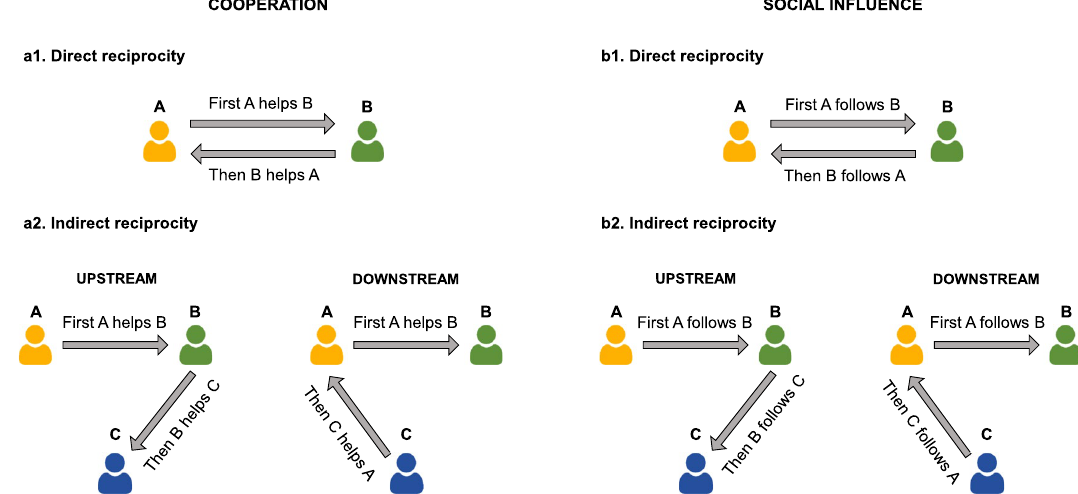
Figure 1. Schematic representation of direct and indirect reciprocity in cooperation ( a1 , a2 ) and social influence ( b1 , b2 ) scenarios. ( a1 ) Direct reciprocity in cooperation. An agent A benefits an agent B and then B benefits A. ( a2 ) Indirect reciprocity in cooperation. In upstream indirect reciprocity, an agent A benefits an agent B and then B benefits a third agent C. In downstream indirect reciprocity, A benefits B and then C benefits A. ( b1 ) Direct reciprocity in social influence. An agent A relies on the opinions of an agent B and then B relies on the opinions of A. ( b2 ) Indirect reciprocity in social influence. In upstream indirect reciprocity, an agent A relies on the opinions of an agent B and then B relies on the opinions of a third agent C. In downstream indirect reciprocity, A relies on to the opinions of B and then C relies on the opinions of